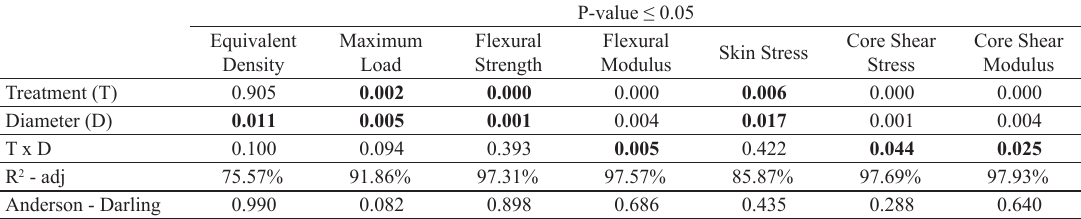
Table 5. Analysis of variance (ANOVA).